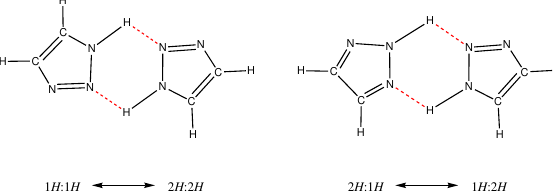
Figure 6. Two concerted mechanisms for tautomerization of triazoles. Rauhut [45] investigated these two mechanisms in gas phase with a reaction barrier of